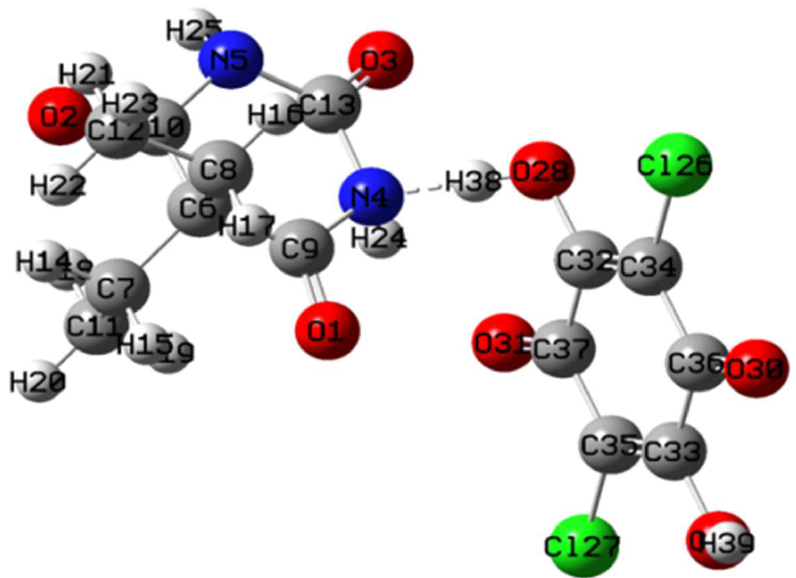
Figure 9. Optimized structure of the (Bar–CLA) complex with the Mulliken atom-numbering scheme.